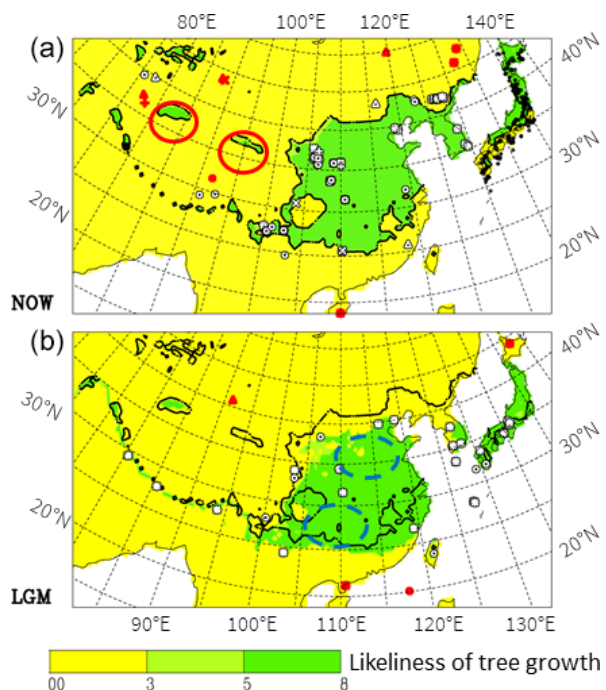
Figure 6. Possible tree growth according to our limitations given in Table 1. Darker colours (green) mean that the climate data suggest possible tree growth. For easier comparison between the present (a) and the LGM (b) , the limits for the present are copied as a solid line into the LGM panel. Markers indicate where and which tree pollen of deciduous trees are found. Markers: circles – Quercus , squares – Tilia , triangles – Ulmus , plus – Juglans and stars – more than one taxon. For modern-day sites in Japan only dots are used for clarity of the plot. Open markers indicate that, at least within a distance of approximately three grid points ( ∼ 150km radius), the climate data suggest possible tree growth; otherwise, filled (red) markers are used. Red and blue (dashed) ovals show areas of interest mentioned in the